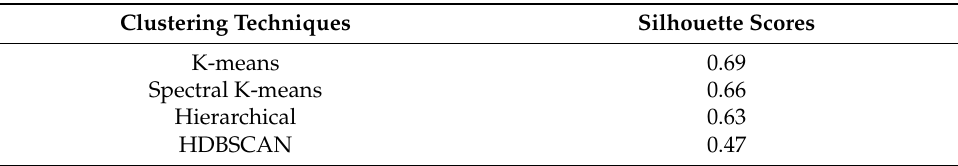
Table 2. Silhouette scores of different clustering